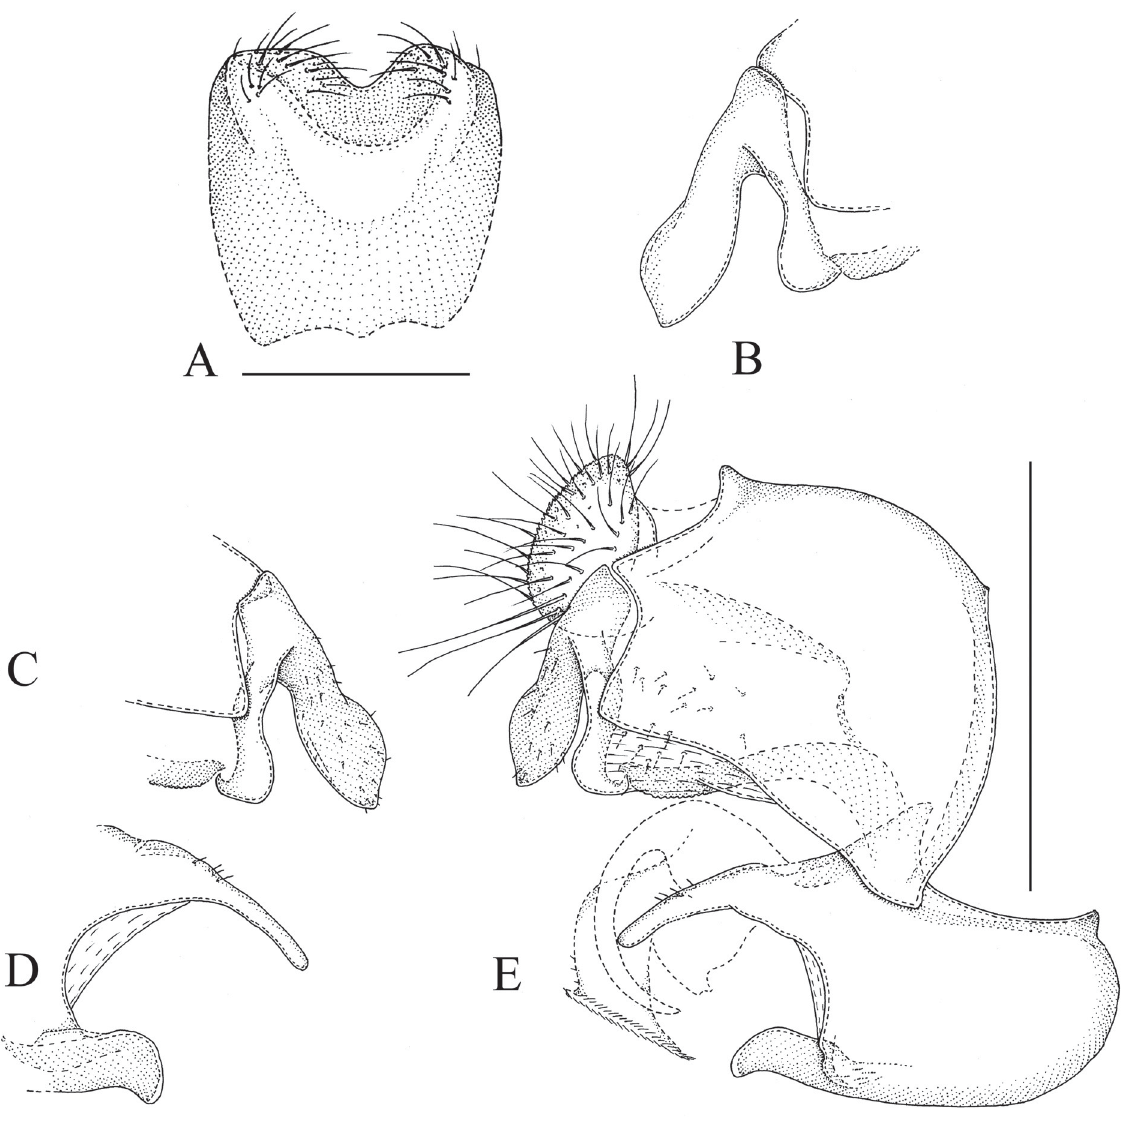
Fig. 68. Sphegina (Asiosphegina) or ientalis Kertész, 1914, ♂ , Taiwan, specimen 1 (A), ♂ , Taiwan, Mingchih, specimen 2 (B–E). A . Sternum IV, ventral view. B . Right surstylus, postero-lateral view. C . Left surstylus, lateral view. D . Left superior lobe with associated parts, lateral view. E . Genitalia, right side, lateral view. Scale bars = 0.5